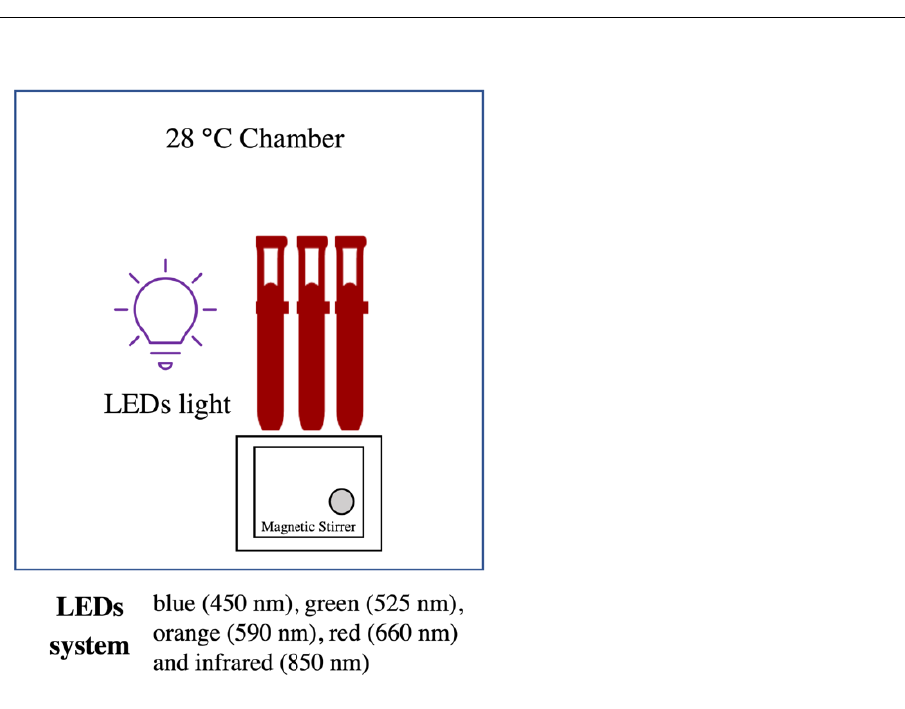
Figure 1. Schematic diagram of LED-assisted T. purpurogenus extracellular-pigment-mediated AgNP biosynthesis.